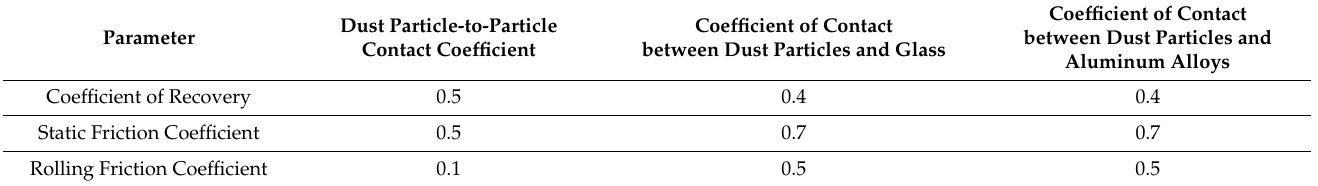
Table 2. Solar panel and dust physical parameters.